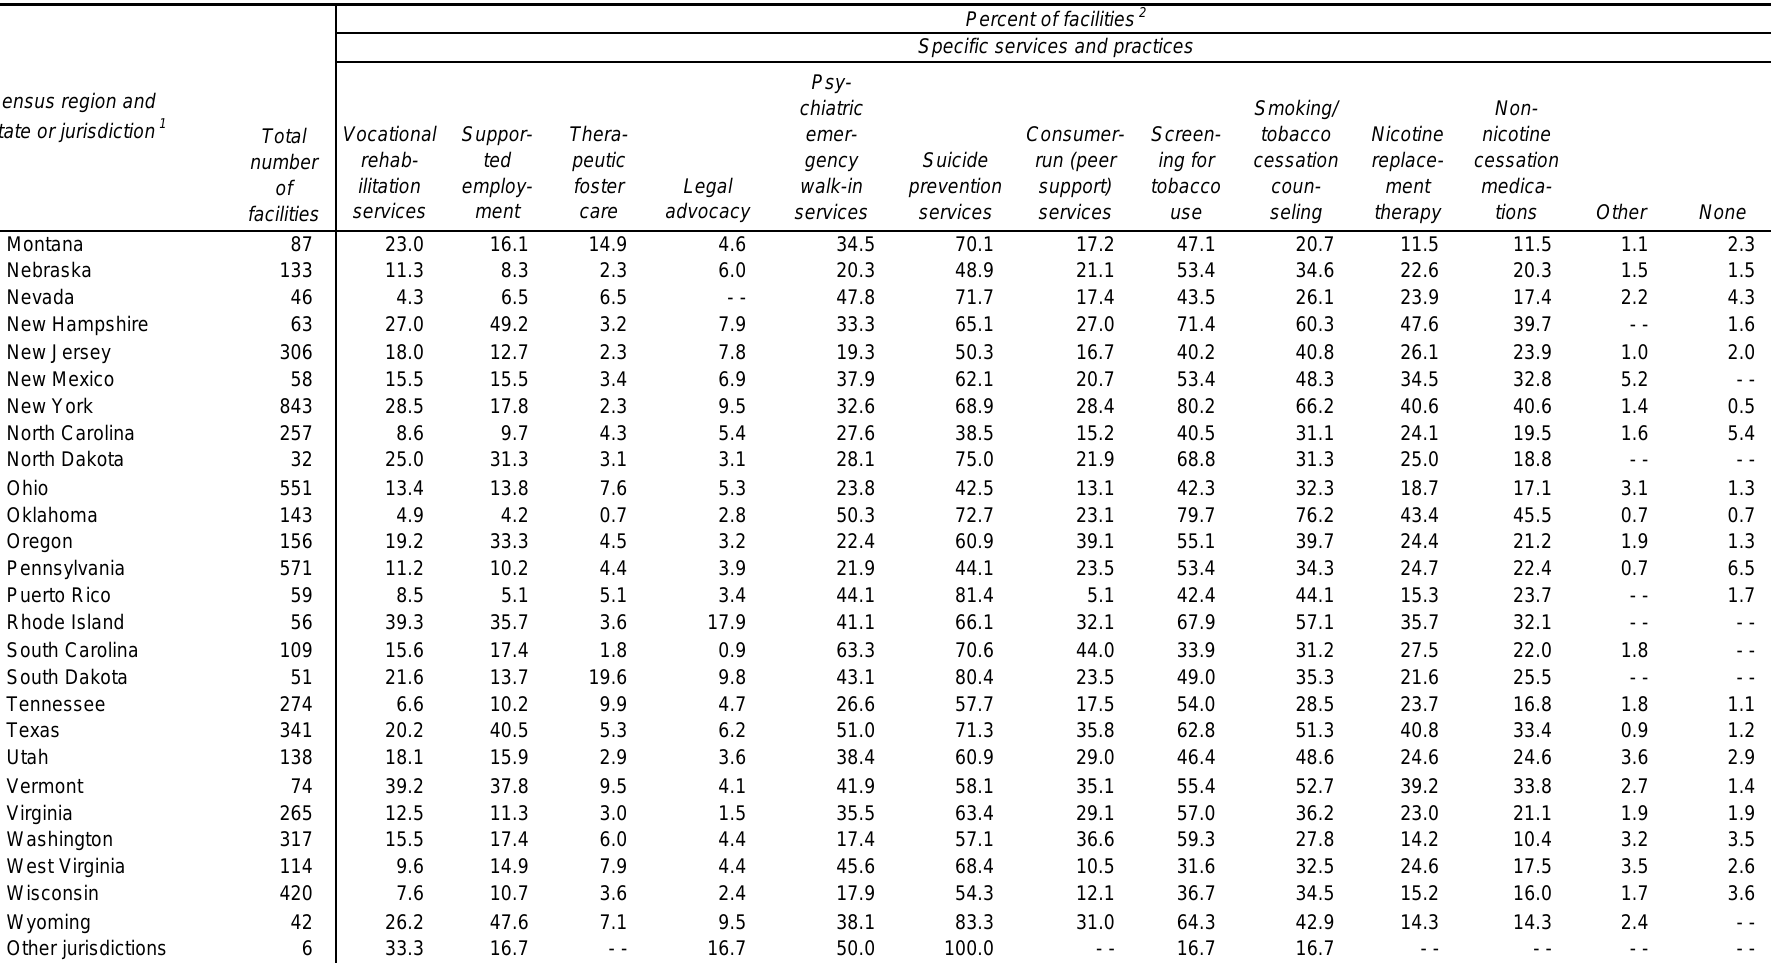
Table 3.8b. Mental health treatment facilities offering specific services and practices, by Census region and state or jurisdiction: Percent, 2017 (continued)